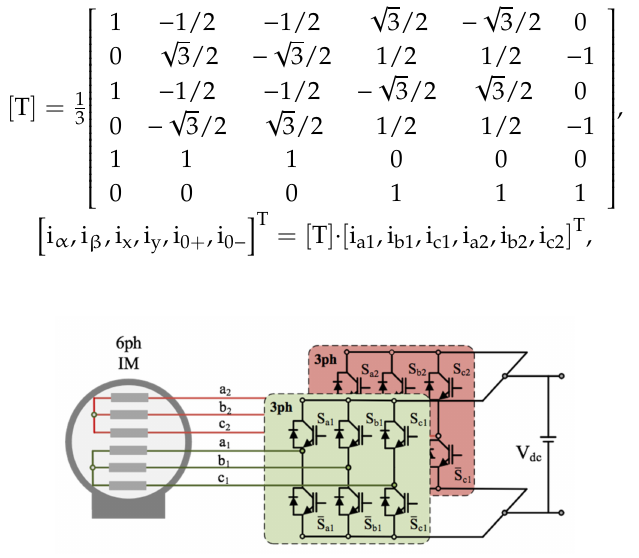
Figure 1. Six-phase drive